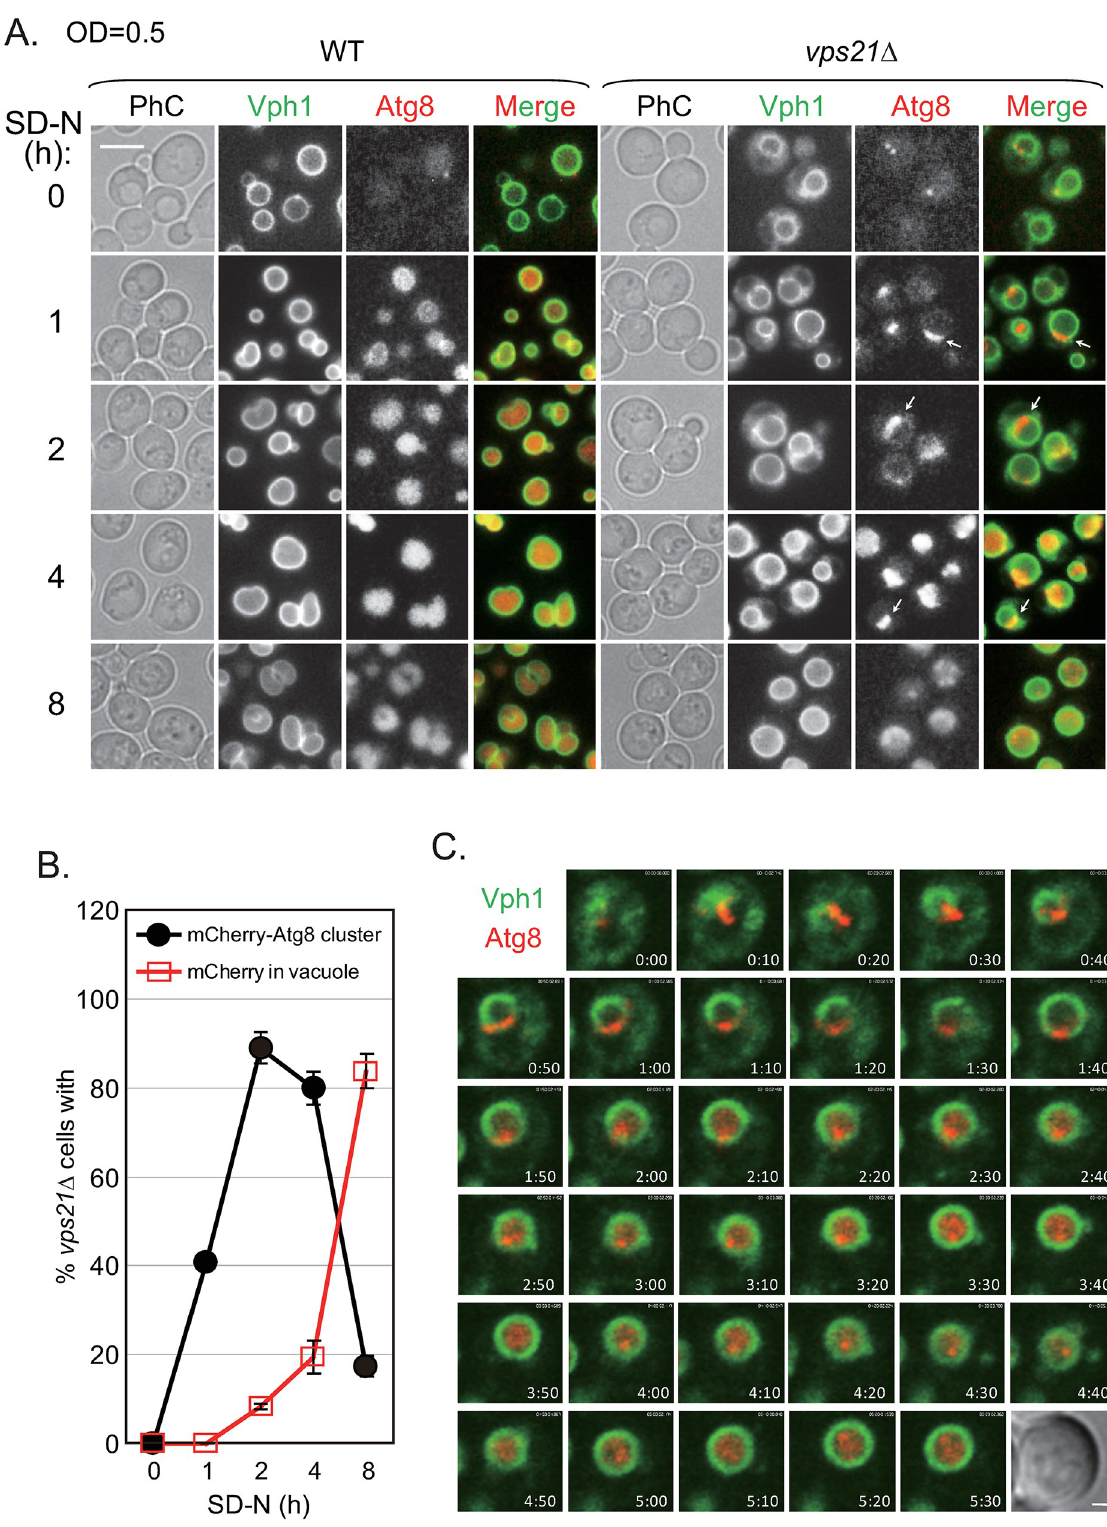
Fig 5. The entry of accumulated mCherry-Atg8-labeled clusters into vps21 Δ cell vacuoles after prolonged nitrogen starvation. WT and vps21 Δ cells labeled with Vph1-GFP and mCherry-Atg8 were subjected to prolonged nitrogen starvation as described in Fig 2A, except that the cell density was set to an OD 600 of 0.5 before nitrogen starvation in order to show more Atg8 clusters. A. The accumulated mCherry-